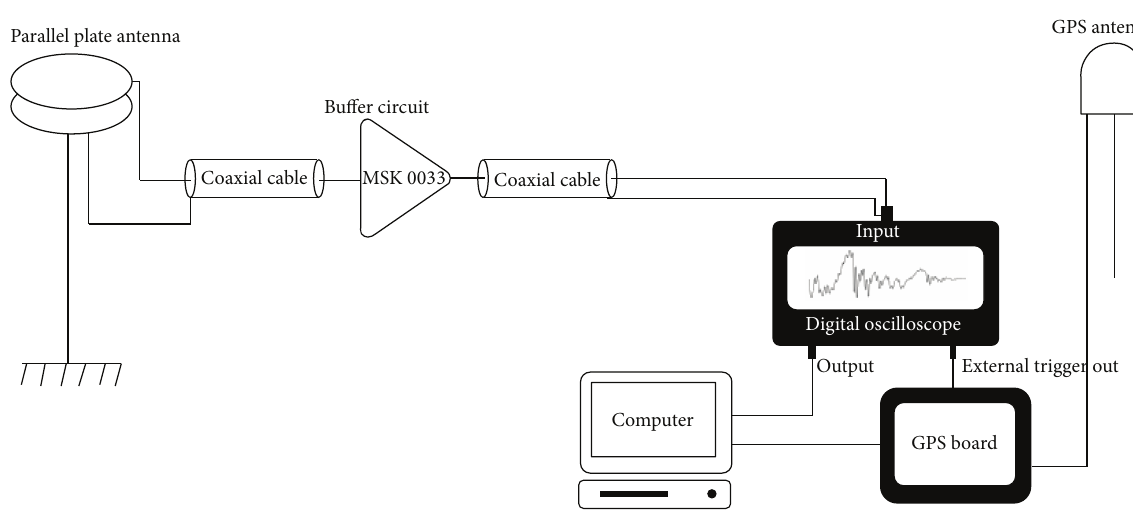
Figure 1: Schematic description of the lightning detection